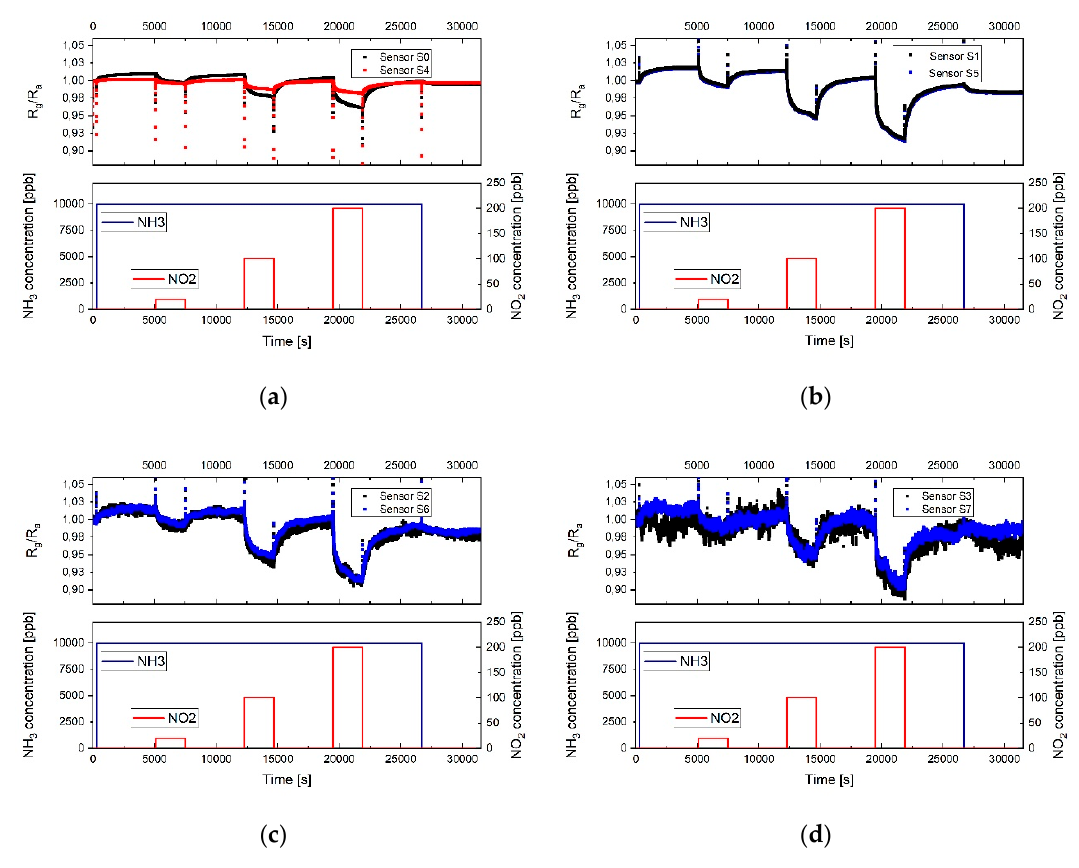
Figure 15. Dynamic response of the sensors towards 10 ppm NH 3 and different concentrations of NO 2 : ( a ) Sensors S 0 and S 4 , ( b ) sensors S 1 and S 5 , ( c ) sensors S 2 and S 6 , ( d ) sensors S 3 and S 7 . The temperature of the heater underneath the sensor was 250 °C and the relative humidity in the test cell was 20% (at room temperature).